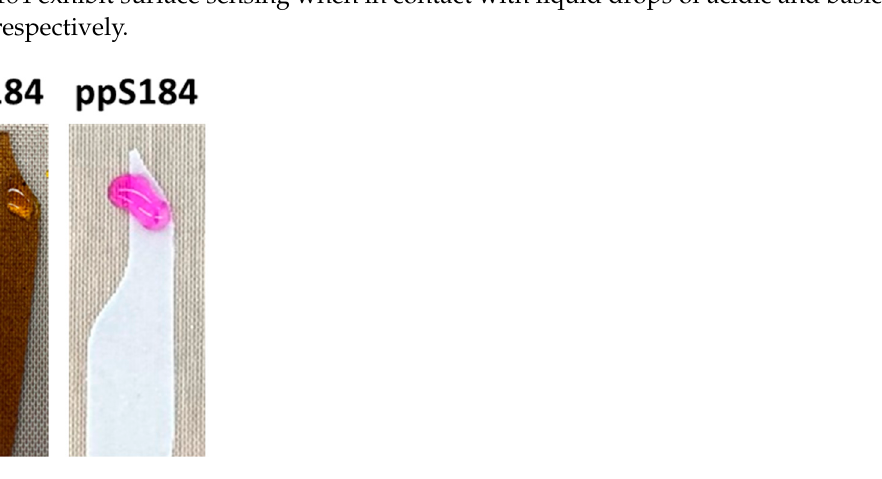
Figure 5. Surface sensing properties of mrS184 and ppS184. Observe that the sensors themselves did not change color but the clear liquid that was applied did.